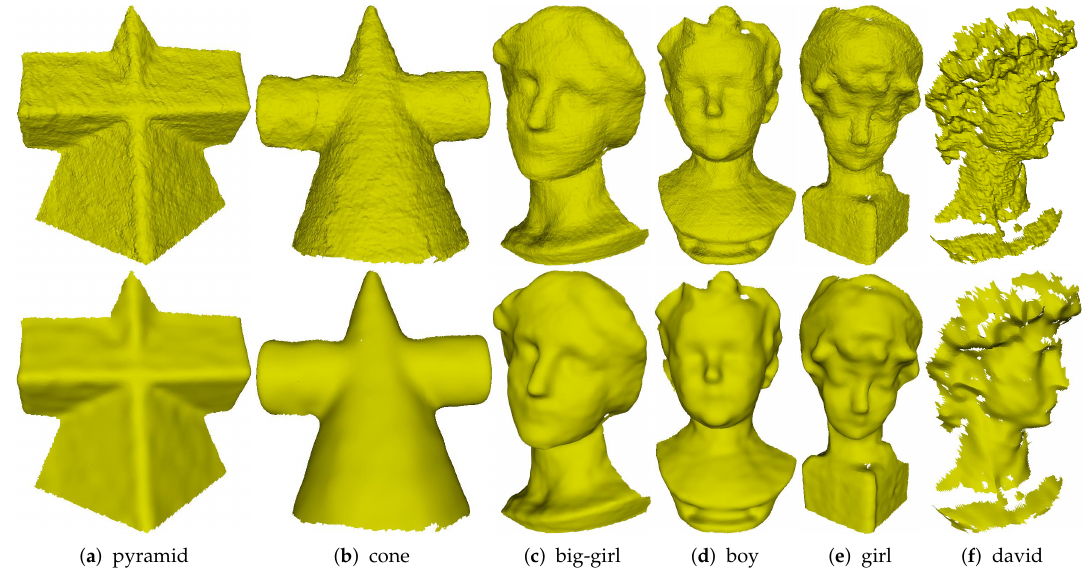
Figure 9. Denoising results of Kinect-scanned models.